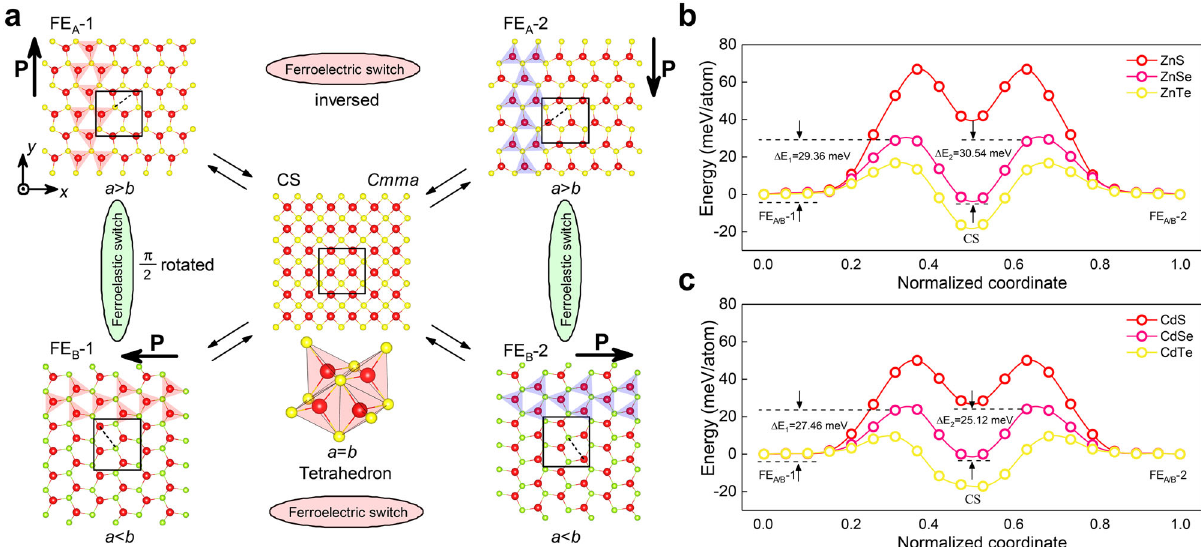
Fig. 3 Ferroelectric/ferroelastic transition. a Detailed phase change process between the FE, FC, and CS structures. The raised magnitude of triangle in either FE A/B -1/2 structure is increased to transform into tetrahedron (CS phase) then decreased to restore the triangle with inversed or π /2 rotated con fi gurations, which forms the multiferroic phase change channel. b, c Phase change barrier for the wz monolayers, indicating the optimal candidates ZnSe and CdSe with benign transition energies between the FE A/B -1/2 and CS phases. Here the Δ E 1 and Δ E 2 depict the barrier heights for the phase change